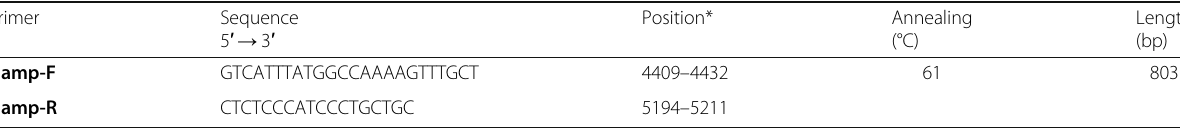
Table 1 Characteristics of primers used in amplification reactions